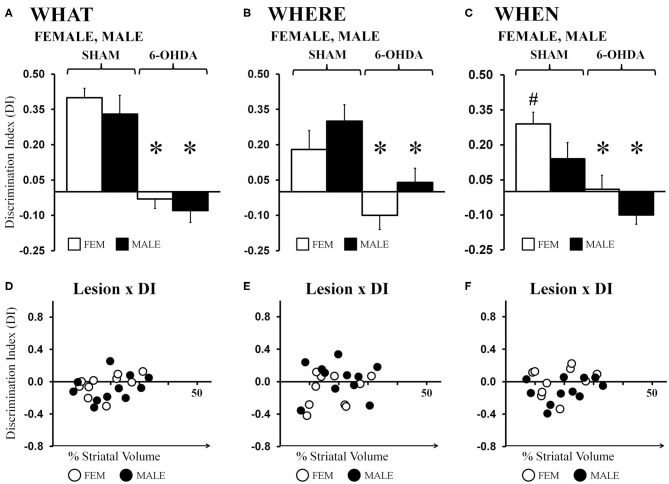
Bar graphs showing average “What” (A), “Where” (B), and “When” (C) discrimination indices (DIs) calculated from object exploration in Test Trials for gonadally intact sham-operated (SHAM) and 6-hydroxydopamine lesioned (6-OHDA) female (FEM, white) and male (MALE, black) rats. DIs for all domains were robust for FEM SHAM and MALE SHAM; trends for MALE over FEM advantage for “Where,” and FEM over MALE advantage for “When” were also seen. In contrast, DIs for all domains were impaired in FEM 6-OHDA and MALE 6-OHDA groups. Results from post-hoc comparisons are shown as follows: significant differences in DIs between the SHAM and 6-OHDA lesioned female and male rats (*); near significant differences in “When” discrimination between the SHAM-lesioned FEM and MALE groups (p = 0.053, #). Scatter plots of “What” (D), “Where” (E), and “When” (F) DIs expressed as functions of the size (percent of total striatal volume) of 6-OHDA lesions for individual gonadally intact FEM (white circles) and MALE (black circles) rats show no significant or consistent relationships between the two.